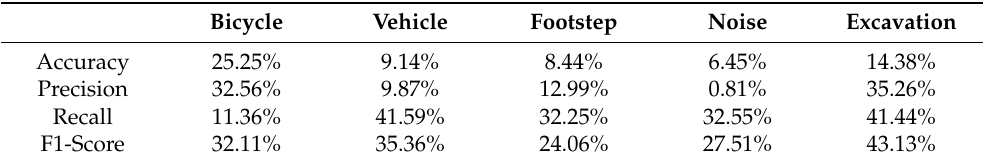
Table 1. The improvement of proposed VMD-HT method on each class and each evaluation indicator compared with other domain